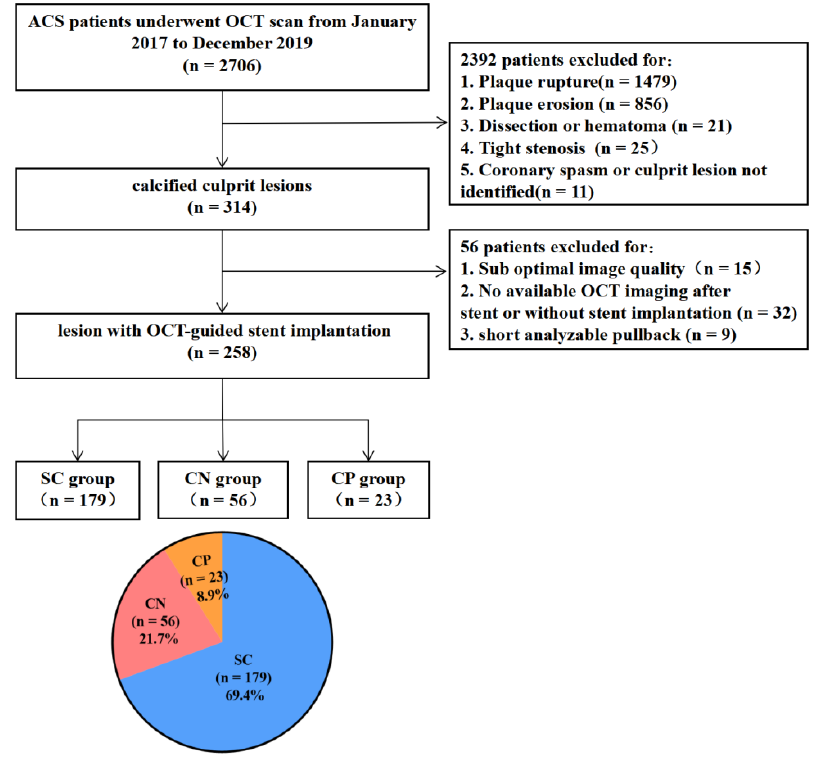
Figure 1. The study flow chart. ACS = acute coronary syndrome; CN = eruptive calcified nodules; CP = calcified protrusion; OCT = optical coherence tomography; SC = superficial calcific sheet. The culprit lesion was identified based on angiographic findings, electrocardiogram changes, and/or left ventricular wall motion abnormalities. In patients with multiple stenoses, the plaque with the most severe stenosis or with evidence of acute thrombus on angiography or OCT was considered to be the